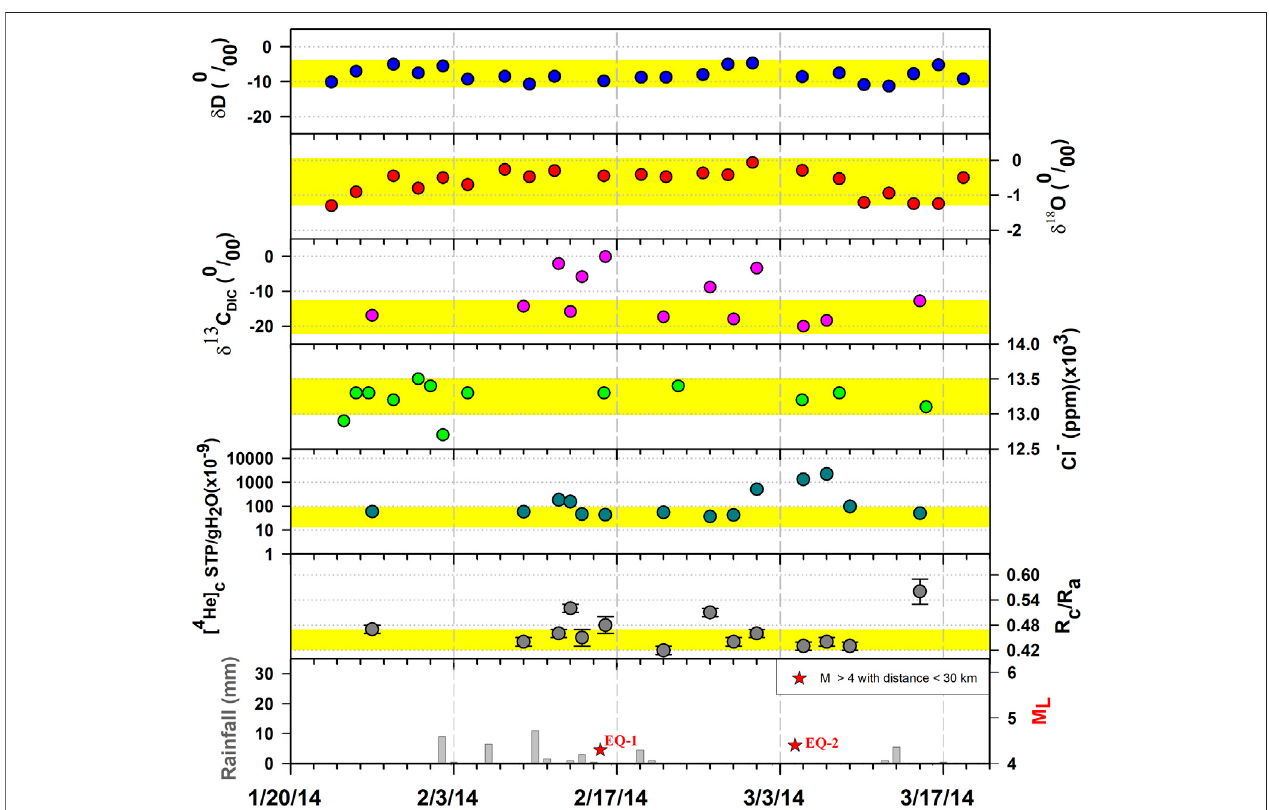
FIGURE 4 | The temporal variations of δ D, δ 18 O, δ 13 C DIC , and 3 He/ 4 He values as well as 4 He and chloride concentrations from January 20 to March 21, 2014. Horizontal yellow bar indicates two standard deviations from the mean of the observed results. Red dashed line denotes the date of the speci fi c seismic events. The magnitudeofrelatedearthquakeswithlocalintensity ≥ 2andhourlyrainfalldataarealsoincluded.Redstarsymbolsindicatethattheepicenterdistanceoftheearthquake to the station was ≤ 30 km with a magnitude ≥ 4.